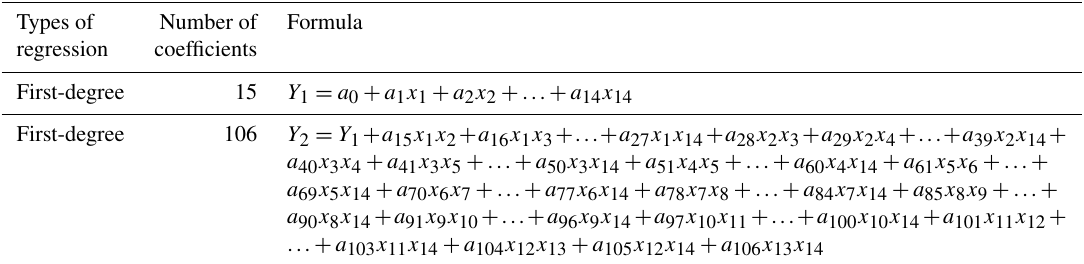
Table 2. Formula of regression models used for ASTER satellite image bands.